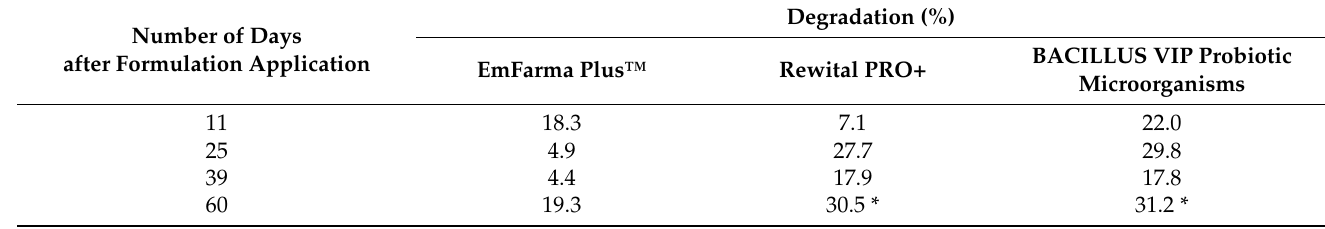
Table 2. Percentage degradation of flurochloridone following application of formulations containing EM versus control samples (the content of herbicide in control samples, on each sampling day, was assumed as 100%).